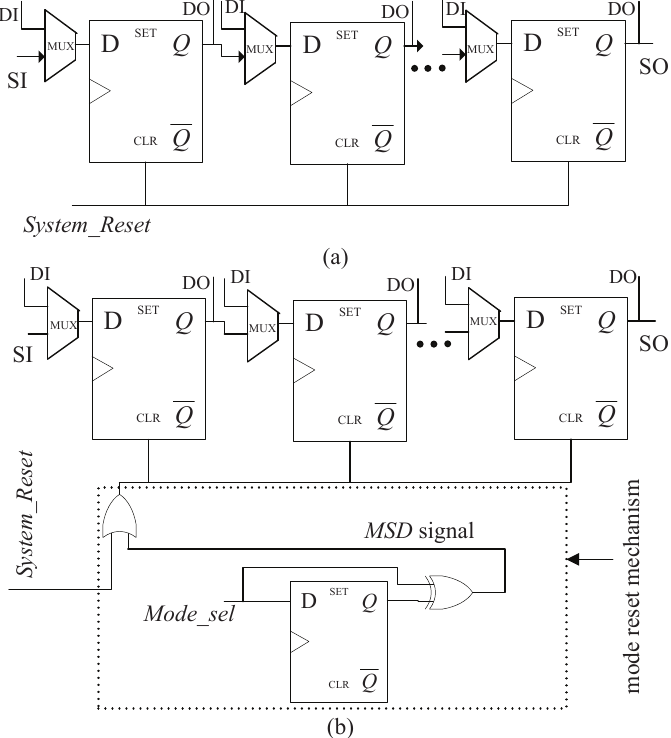
Figure 5. Architecture of scan chain. ( a ) Standard scan chain. ( b ) Secure scan chain with scan chain reset